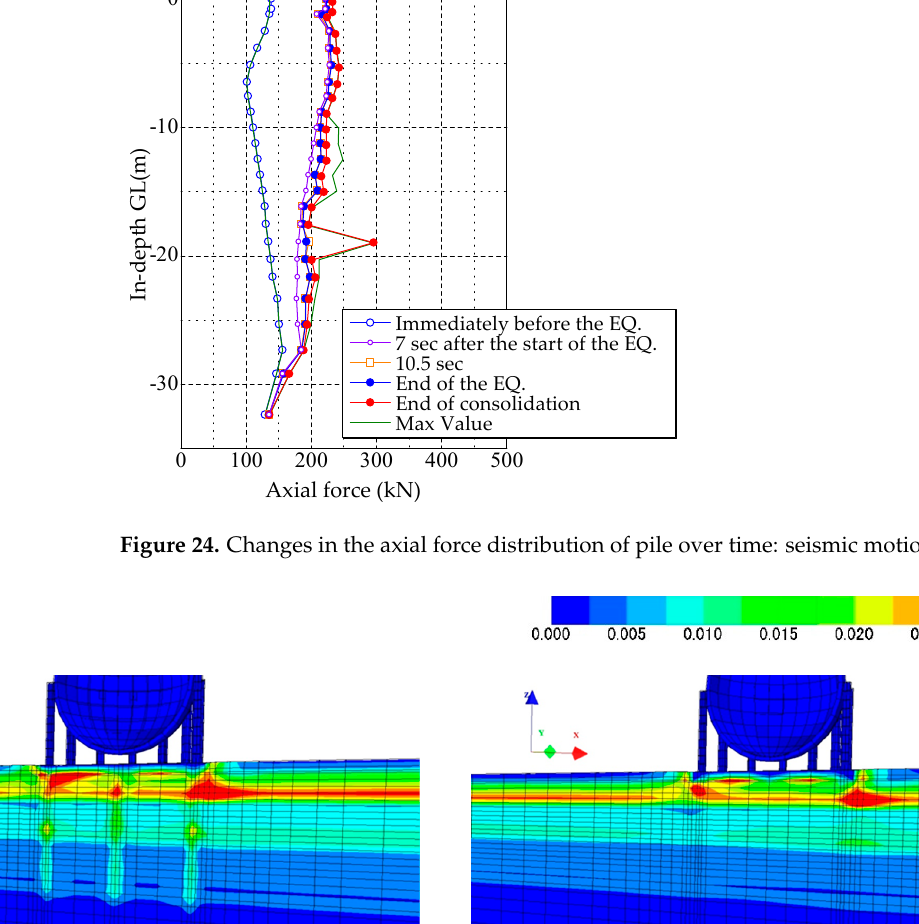
Figure 25. Shear strain distribution (maximum value until the end of an earthquake) of ( a ) with-piles and ( b ) without-piles models: seismic motion (B).